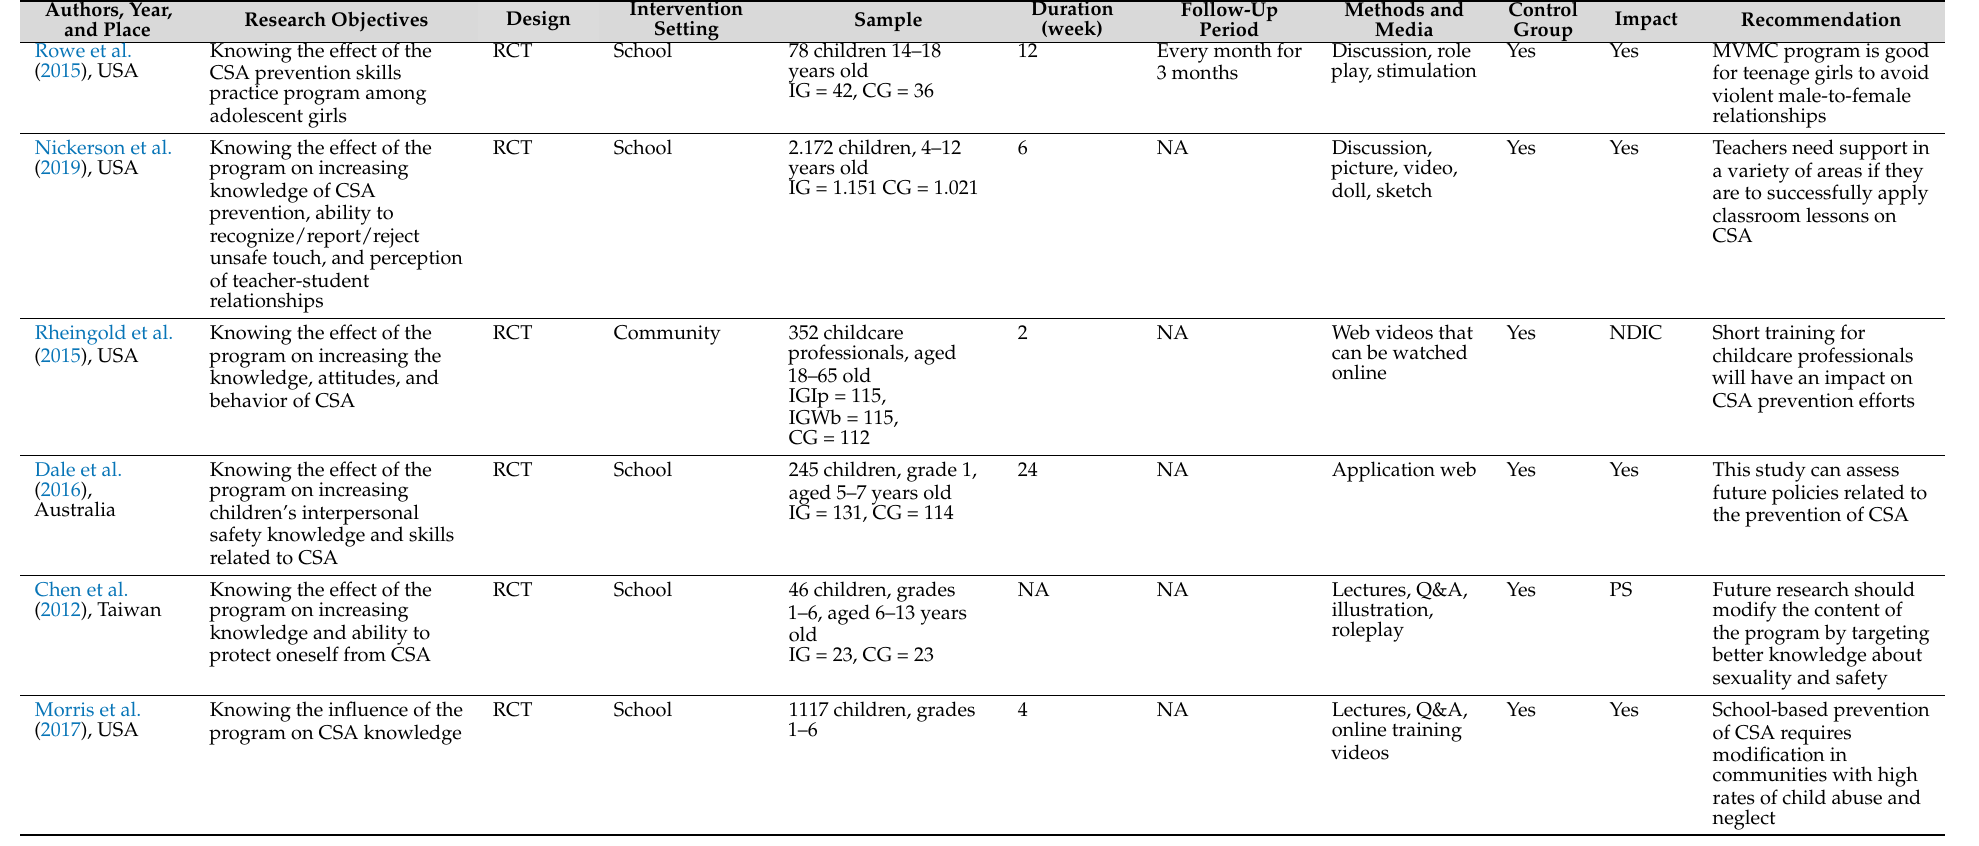
Table 1. Selection results of interventions for prevention of child sexual